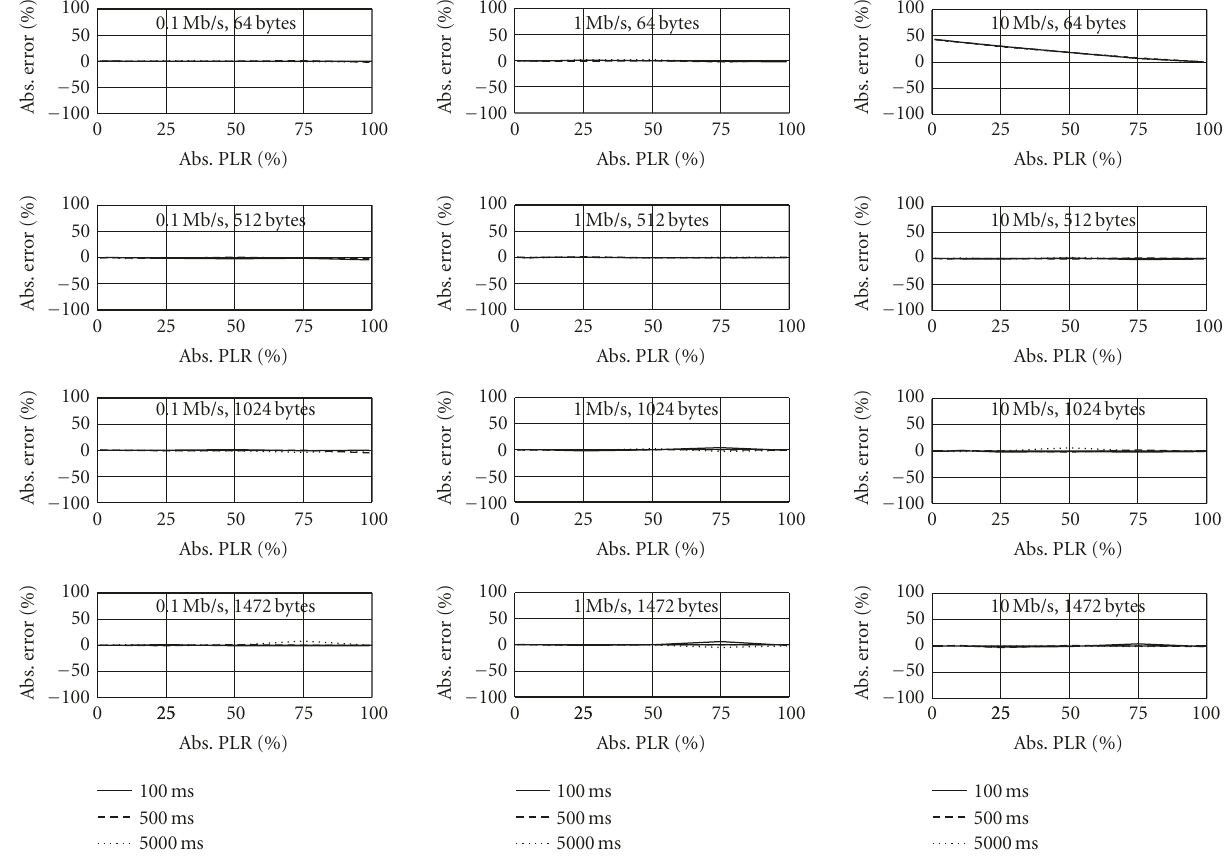
Figure 20: Absolute packet loss accuracy